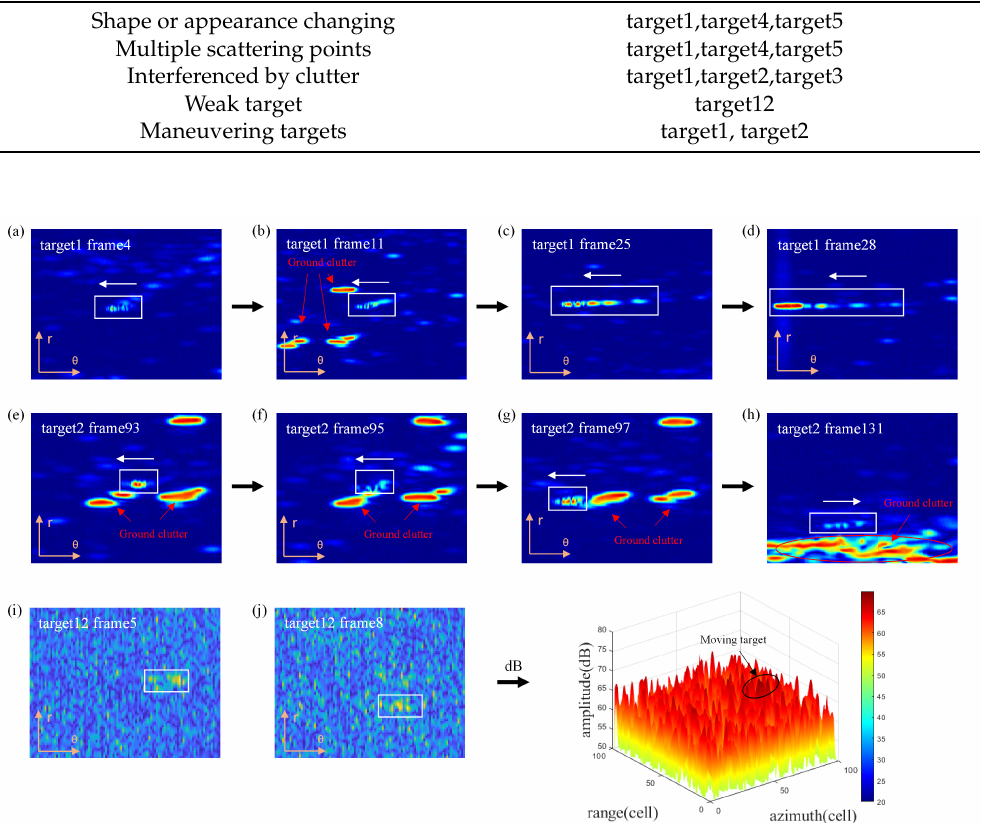
Figure 6. Some challenging targets in monitor scenarios. ( a – d ) Shape or appearance changing. ( e – h ) Targets interferenced by clutter. ( i , j ) Weak